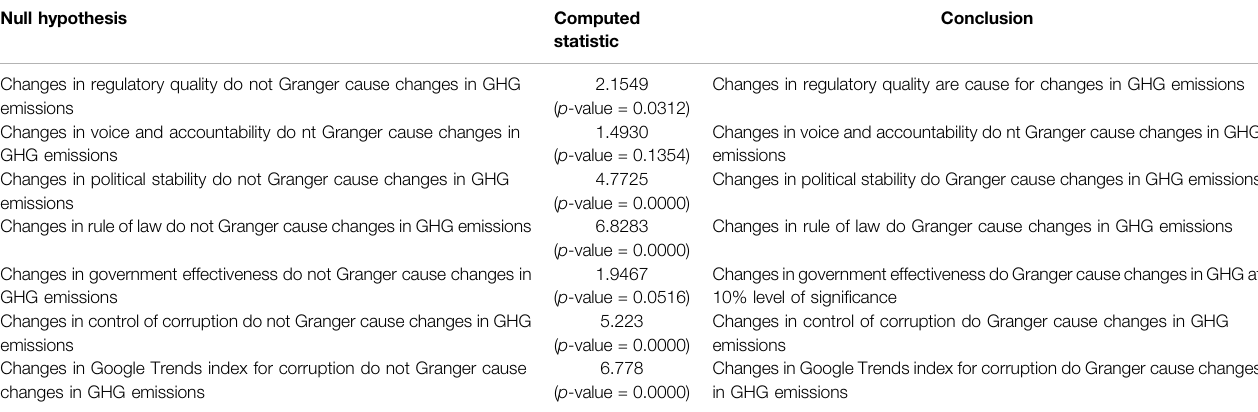
TABLE 9 | Dumitrescu and Hurlin Granger non-causality test results. Null